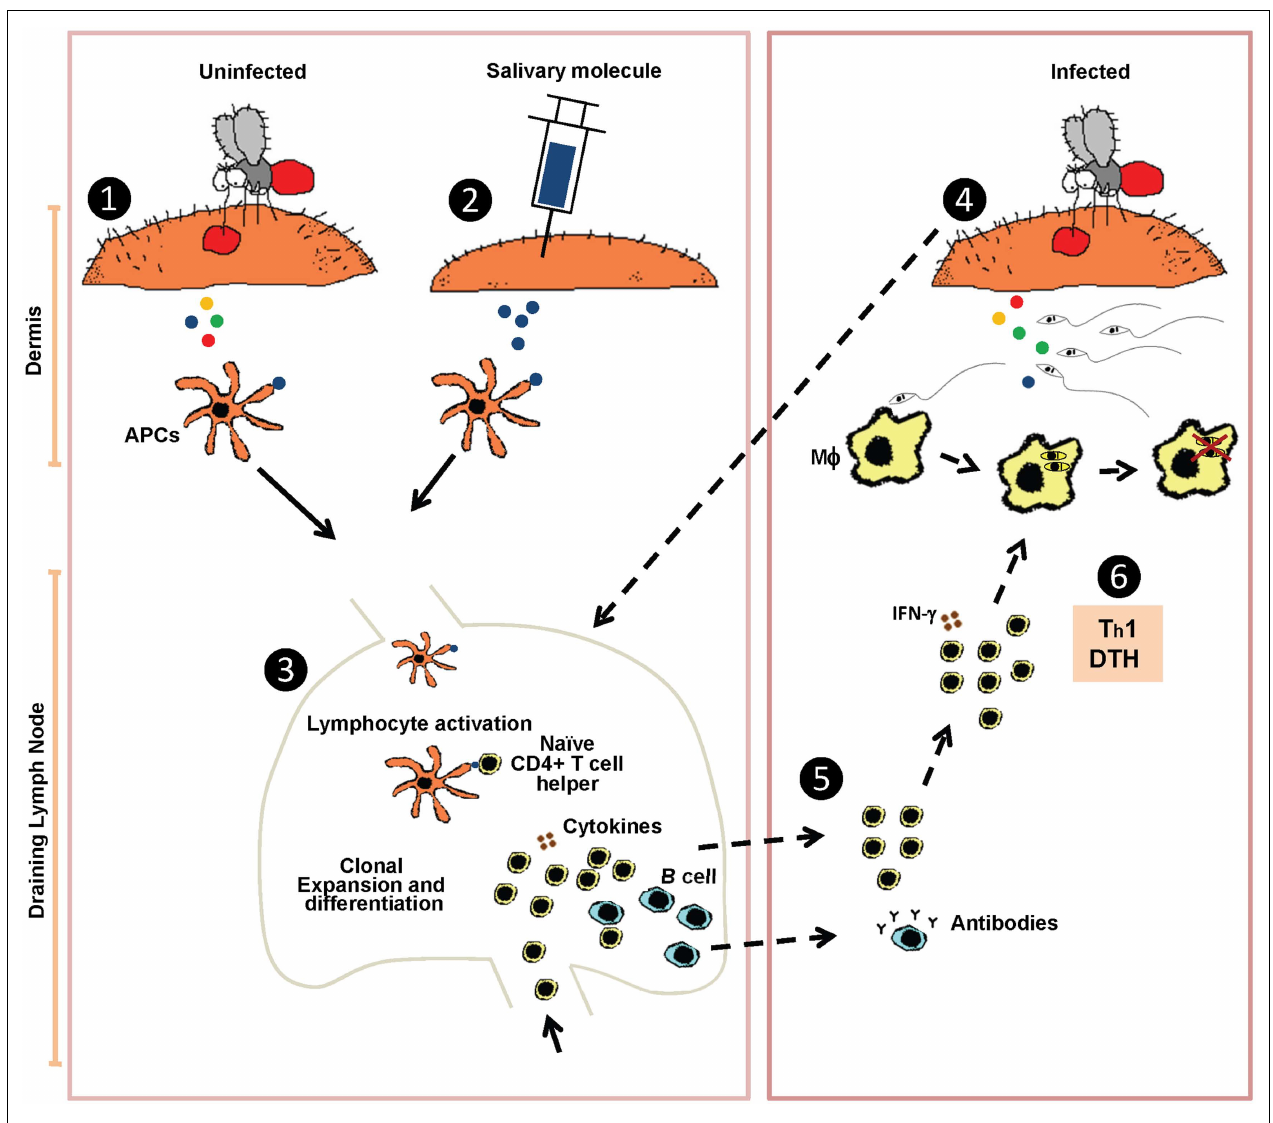
bite (4) it triggers a rapid recruitment of anti-saliva memoryT cells, mostly CD4 + producing IFN- γ , from the draining lymph nodes (dashed arrows) to the site of the sand fly bite. Cellular recruitment generally peaks at 48h after challenge by bite characterized as a delayed-type hypersensitivity reaction (DTH) (5). CD4 + T cells producing IFN- γ will activate macrophages (M φ ) promoting Leishmania killing (Th1 response)